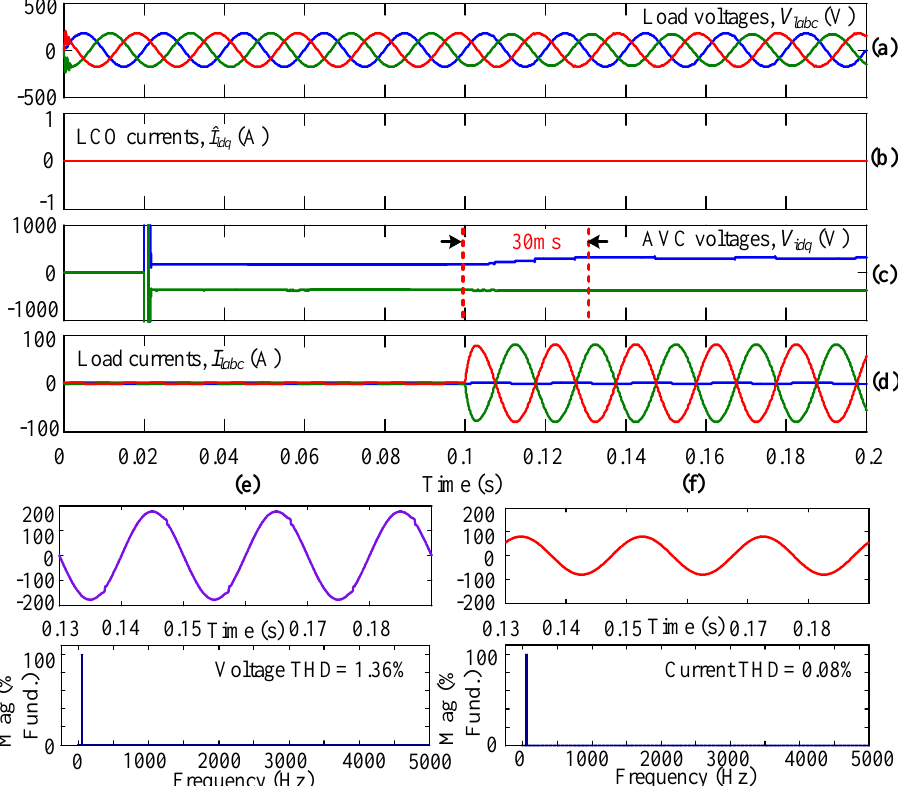
Figure 6. Simulation results for case-I with unbalanced load condition.